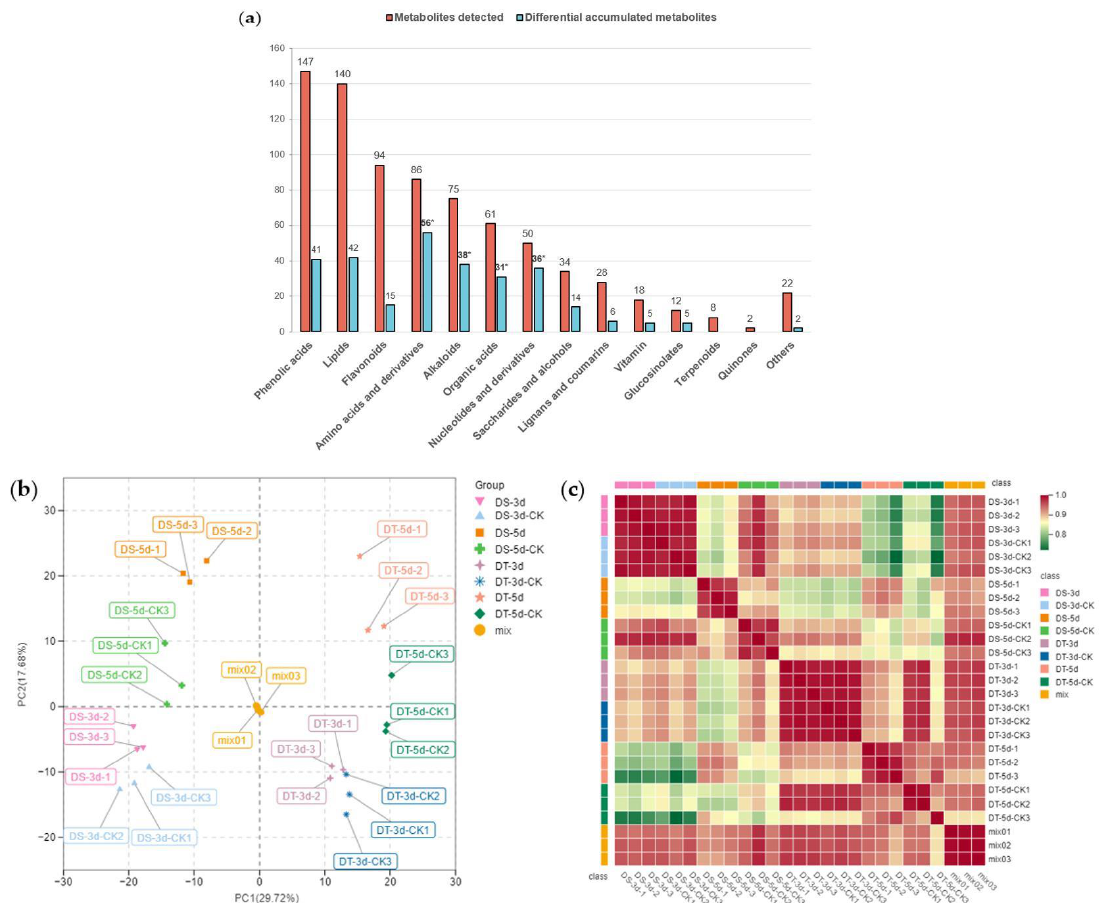
Figure 2. Metabolic profiling of drought − tolerant and susceptible genotypes in response to mild and severe drought stress. ( a ) Number of metabolites and differential metabolites in different classes. The statistical significance was determined via hypergeometric test with * P < 0.05; ( b ) Principal component analysis (PCA); ( c ) Heatmap of Pearson’s correlation coefficient. Different colors represent different samples, DS − 3d (pink), DS − 3d − CK (baby blue), DS − 5d(orange), DS − 5d − CK (green), DT − 3d (purple), DT − 3d − CK (dark blue), DT − 5d (lightsalmon), DT − 5d − CK (dark green), mix (golden